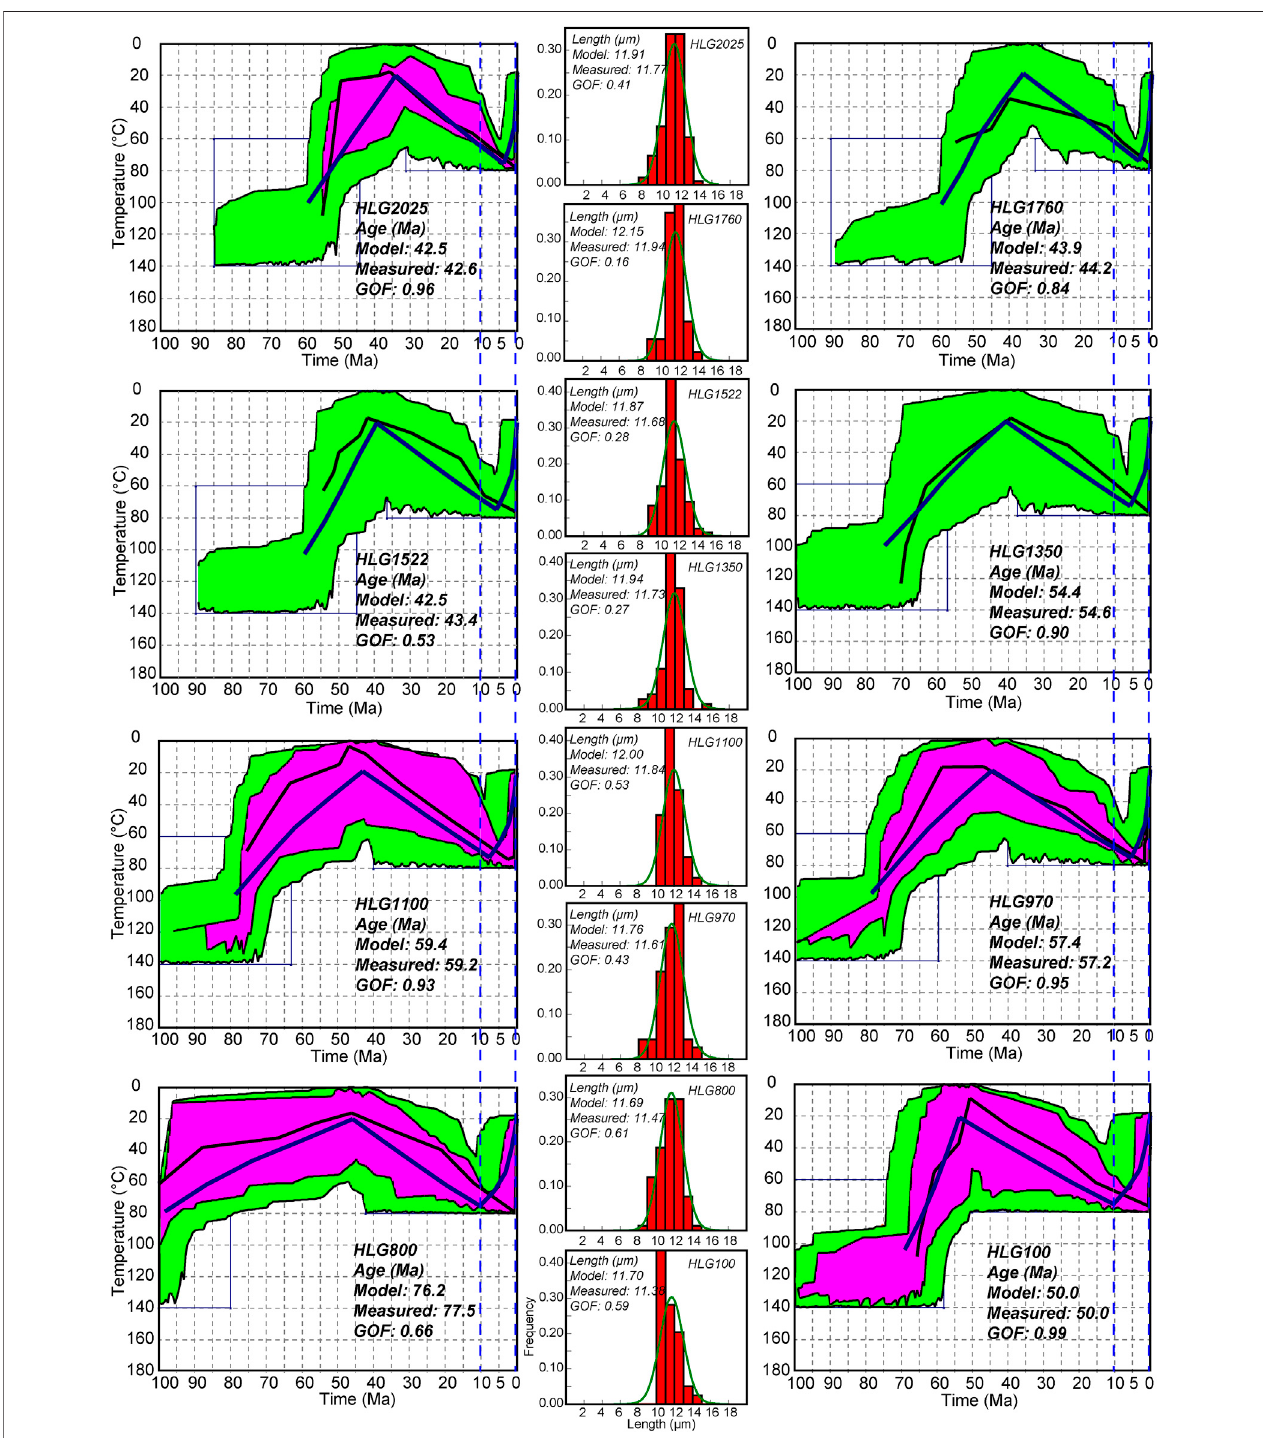
FIGURE8| InferredthermalhistoriesforsamplesinthenorthernQaidamBasinmodeledbyHeFTyprogram(Ketcham,2005).Goodpaths(GOF > 0.55)areshown as magentaenvelopes and acceptable paths (GOF > 0.05) asgreen envelopes. The dark blue lines represent the weighted mean thermal paths for all models, and black lines are the best fi t thermal paths. GOF (cid:1) goodness of fi t.